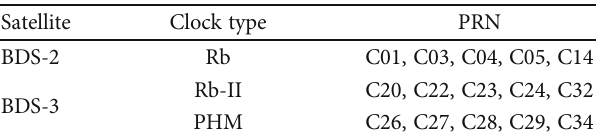
Table 1: Types of BDS satellite clocks used in this work.